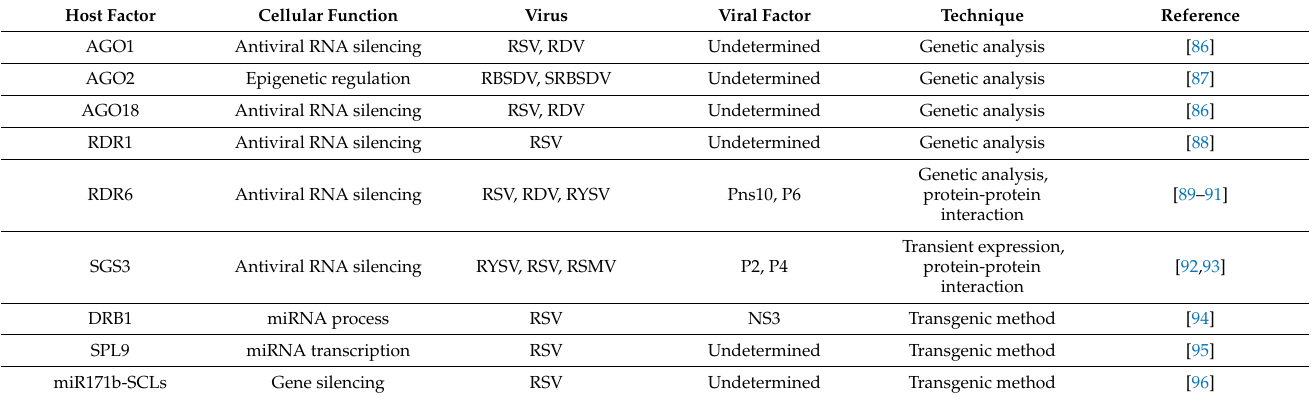
Figure 2. The arms race between rice plants and viruses. Viral proteins execute all parts of virus infection cycle in host cells. They usurp host factors and resources and suppress host defense signals for virus pathogenesis (proviral). Antiviral resistance consists of host factors that target viral proteins or nucleic acids to restrict virus infection (antiviral). The dotted lines and question mark mean there exists uncovered correlations between viral proteins and host factors required for virus pathogenesis or antiviral defense. Table 4. Host factors with antiviral activity against rice